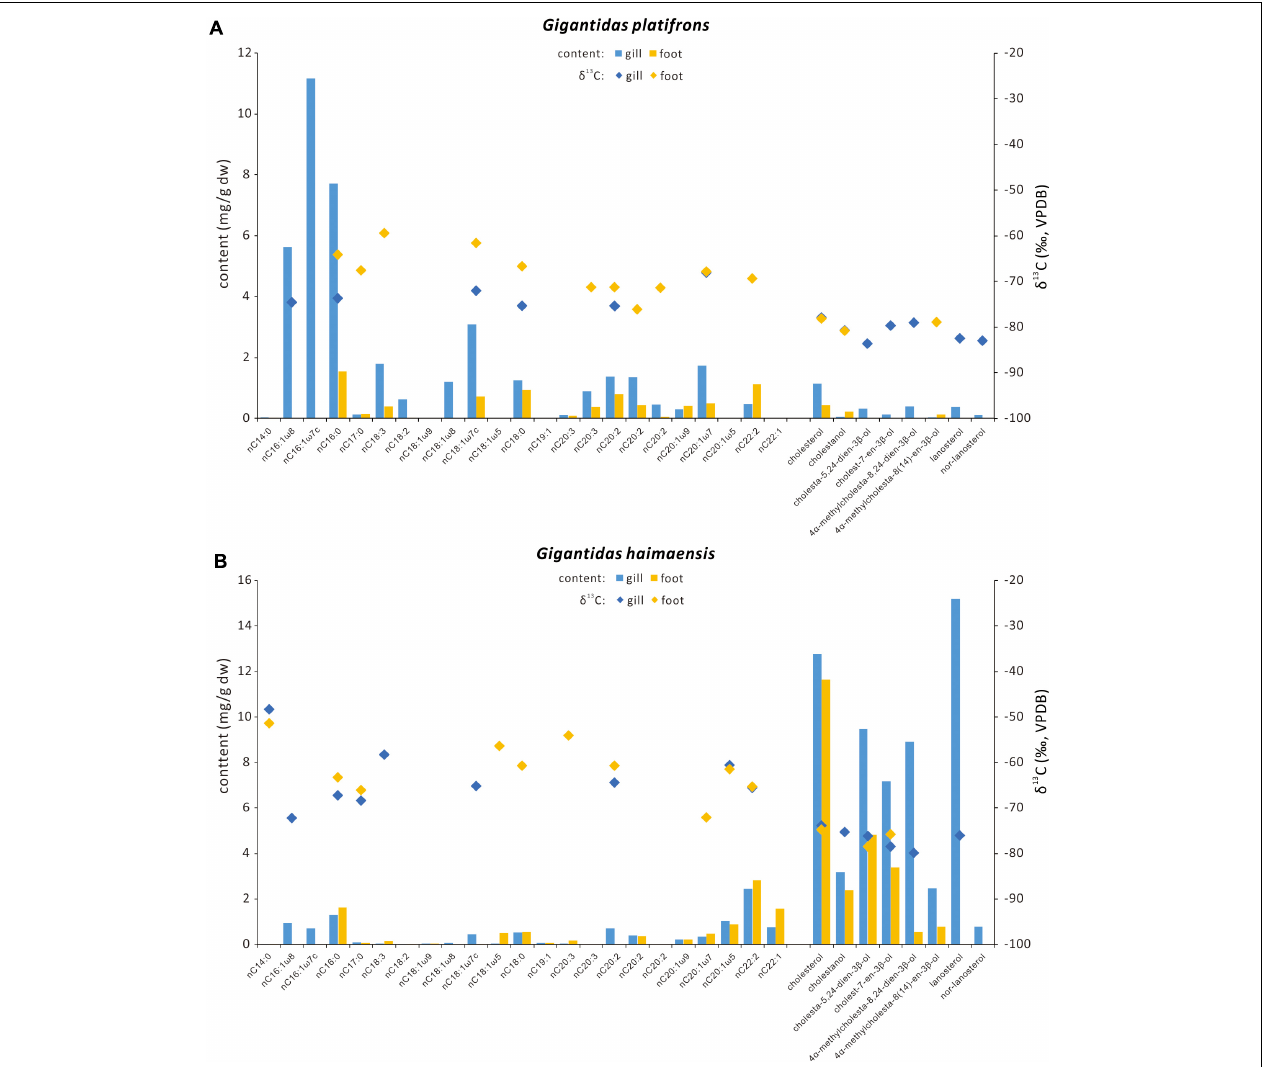
FIGURE 4 | Contents and carbon isotopic compositions of selected fatty acids and sterols for (A) Gigantidas platifrons and (B) Gigantidas haimaensis . Blue bars = contents of gill tissues; orange bars = contents of foot tissues; blue diamonds = δ 13 C values of biomarkers from gill tissues; orange diamonds = δ 13 C values of biomarkers from foot